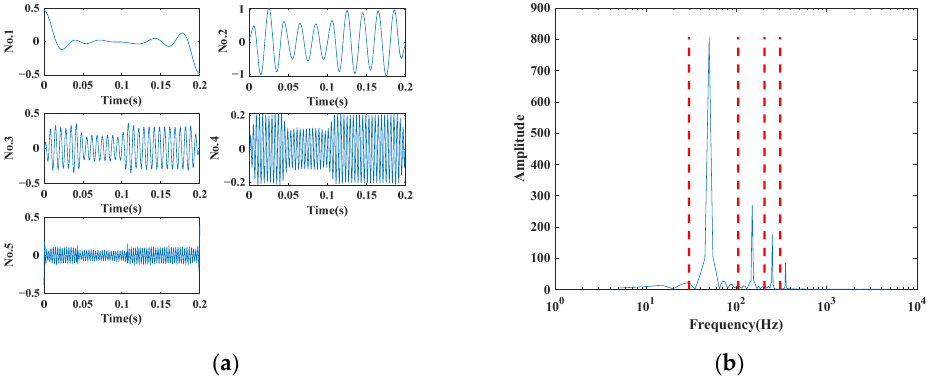
Figure 7. PQD signal decomposition results by EWT when K = 5. ( a ) Results in the time domain; ( b ) Segmented spectrum.